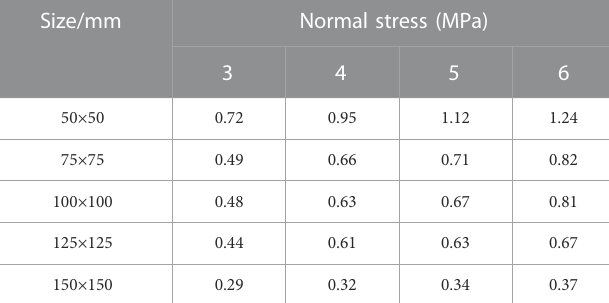
TABLE 10 Relationships between CSS and normal stress. Normal stress (MPa)